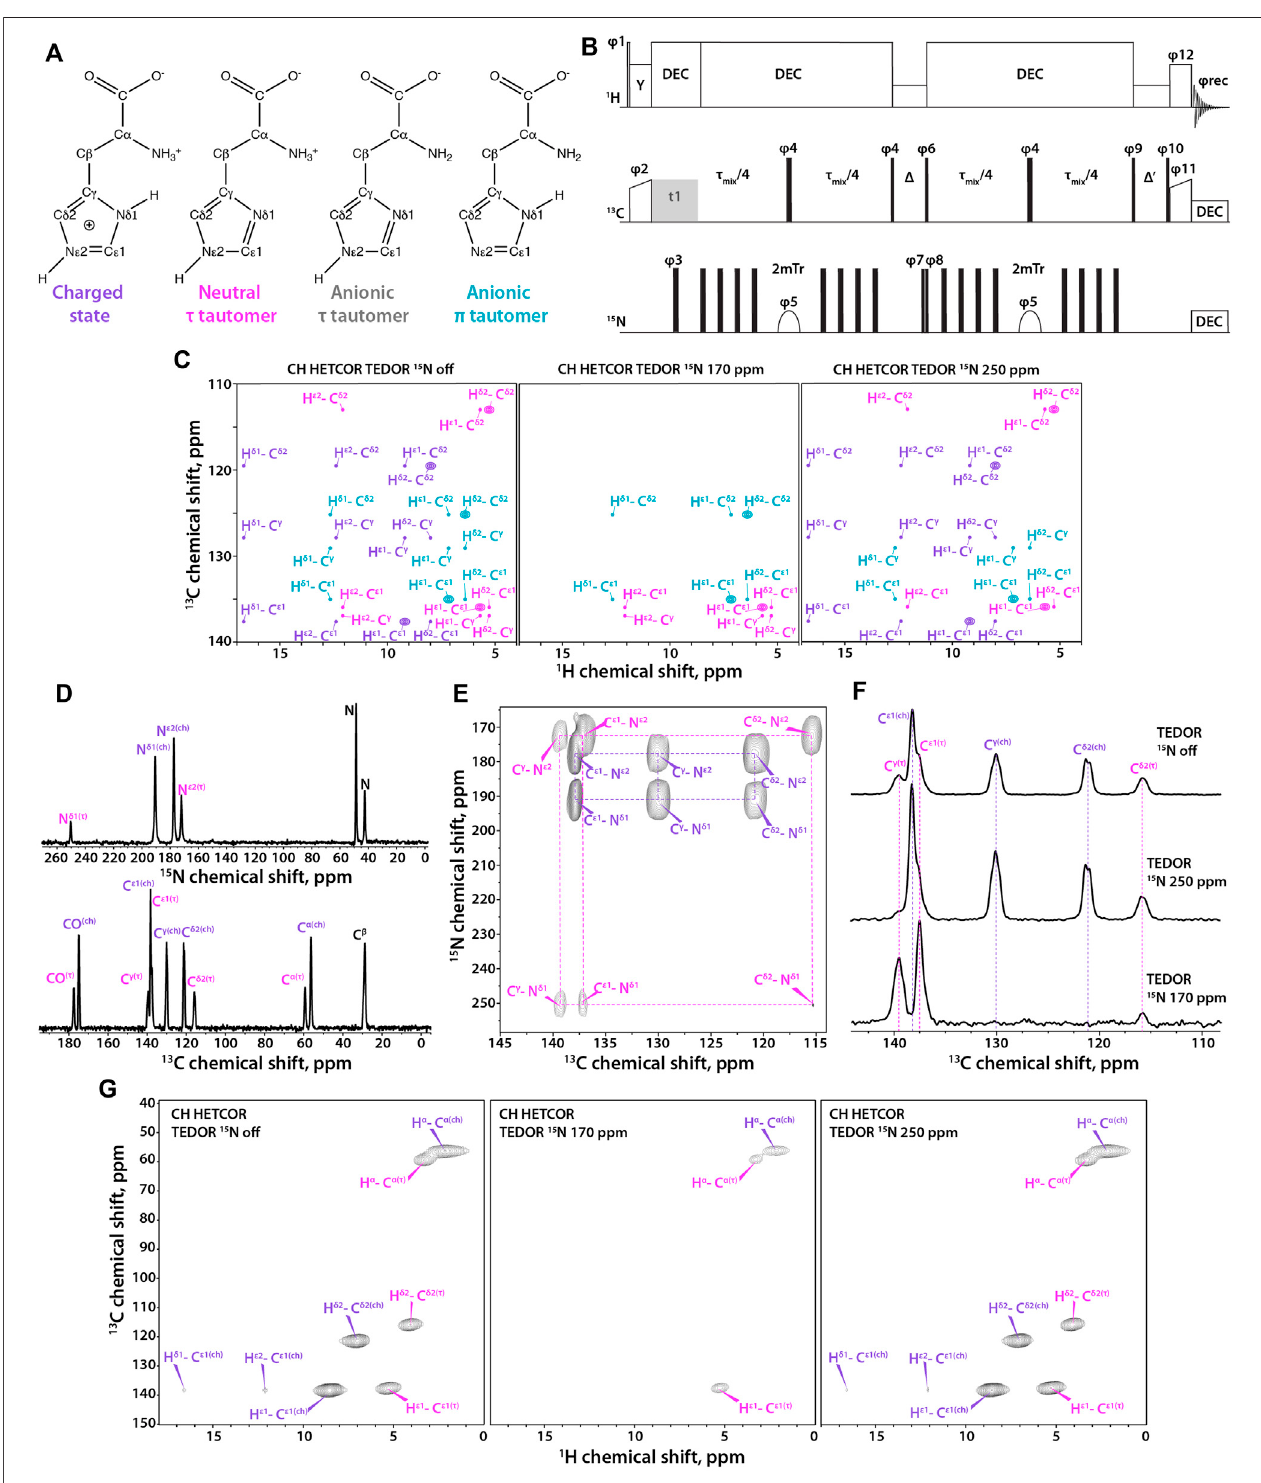
FIGURE 1 |(A) Four states of histidine: left to right, charged state, neutral τ tautomer, anionic τ tautomer, and anionic π tautomer. (B) Pulse sequence for the 1 H-detected TEDOR-based 15 N selective fi ltered experiment. T r is the MAS rotor period, τ mix is the total TEDOR mixing time. The phase on the individual pulses are: φ 1 (cid:1) 16 × (0) 16 × (2), φ 2 (cid:1) 1, φ 3 (cid:1) 0, φ 4 (cid:1) 0, φ 5 (cid:1) 0213 2031, φ 6 (cid:1) 2, φ 7 (cid:1) 0, φ 8 (cid:1) 02, φ 9 (cid:1) 1133, φ 10 (cid:1) 4 × (0)4 × (1) 4 × (2) 4 × (3), φ 11 (cid:1) 4 × (1)4 × (0), φ 12 (cid:1) 4 × (1) 4 × (0) 4 × (1) 4 × (0) 4 × (3) 4 × (2) 4 × (3) 4 × (2), φ rec (cid:1) 3113 0220 1331 2002, where 0 (cid:1) x , 1 (cid:1) y , 2 (cid:1) – x , and 3 (cid:1) – y . Δ is set to one rotor period during which 1 H rf fi eld of ω is applied for effectiveZ- fi ltering.MISSISSIPPIwater suppressionsequenceisappliedduring Δ ′ timeperiod. (C) Synthetic 1 H-detectedTEDOR-based 15 Nselective